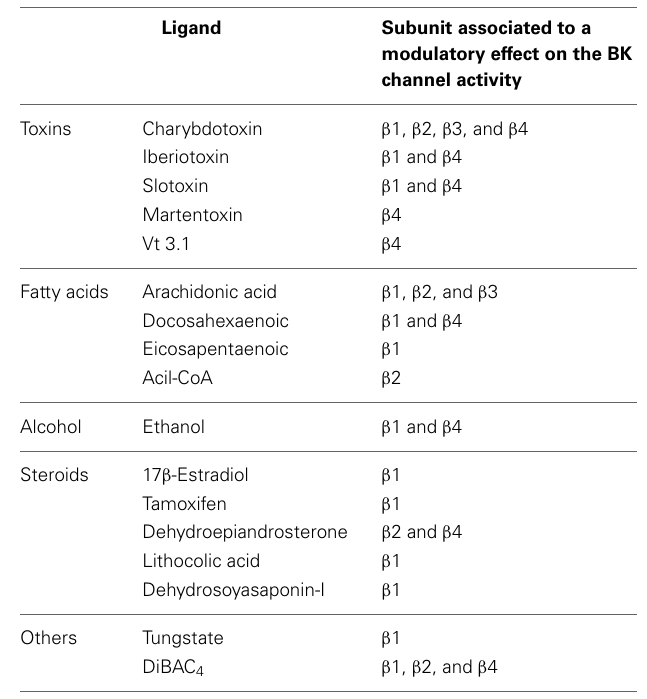
Table 2 | Molecules that regulate BK channel activity through β subunits.